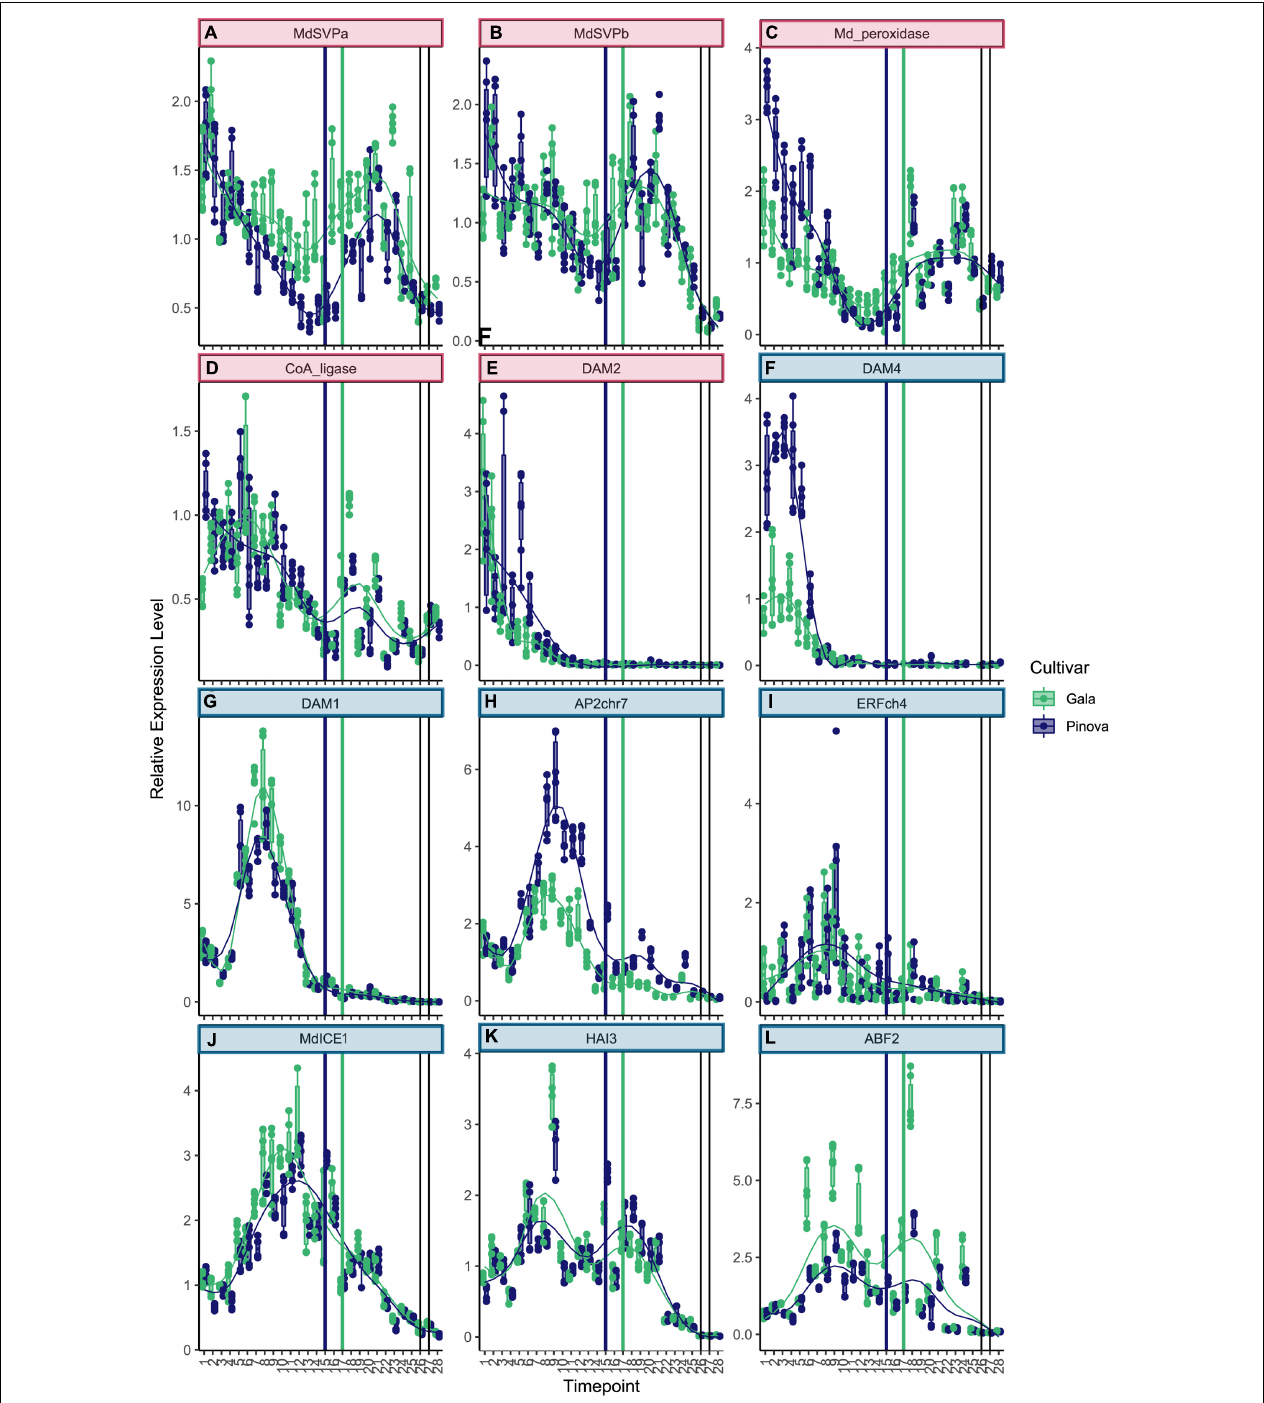
FIGURE 2 | Expression patterns of genes belonging to clusters 1 and 2. (A) MdSVPa, MdSVPb (B) , and Md_peroxidase (C) were highly expressed at the beginning of dormancy, expression levels dropped to a local minimum shortly before the endodormancy to ecodormancy phase transition, and raised again to peak during ecodormancy. (D) CoA-ligase showed a similar pattern. (E) MdDAM2 expression levels were highest at the first three sampling dates during early fall. (F) Expression of MdDAM4 peaked on October 18 in both cultivars, levels were higher in ‘Pinova’ (blue) compared with ‘Gala’ (green). (G) MdDAM1 peaked on November 23, similar to AP2chr7 (H) and ERFchr4 (I) . (J) The expression curve of MdICE was broader. (K) The expression pattern of HAI3 and ABF2 (L) showed two peaks. Cluster number is indicated by colored box harboring the gene name. The colors of the boxes match the cluster colors in Figure 1 . Blue and green dots represent ‘Pinova’ and ‘Gala’ samples, respectively. Vertical lines mark the transition from ecodormancy to endodormancy of ‘Pinova’ (blue, January 17) and ‘Gala’ (green, January 31, 2018). Gray vertical lines indicate the time of bud break. Numbers on the x -axis indicate sample collection dates specified in Supplementary Table 3 .